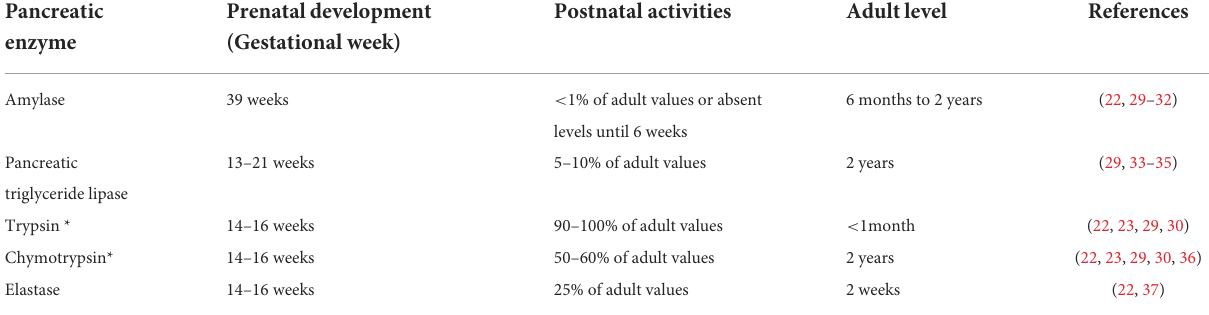
TABLE 1 Ontogeny of common pancreatic enzymes in humans.